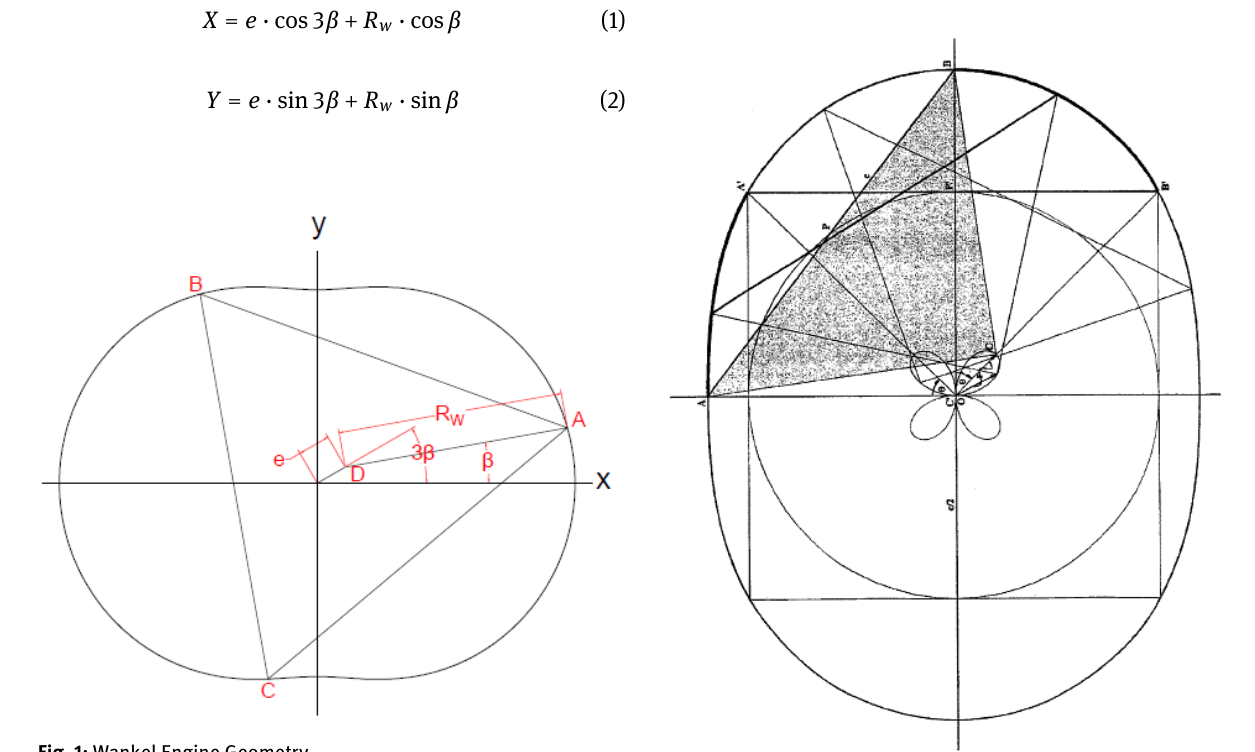
Fig. 2: Szorenyi engine curve construction